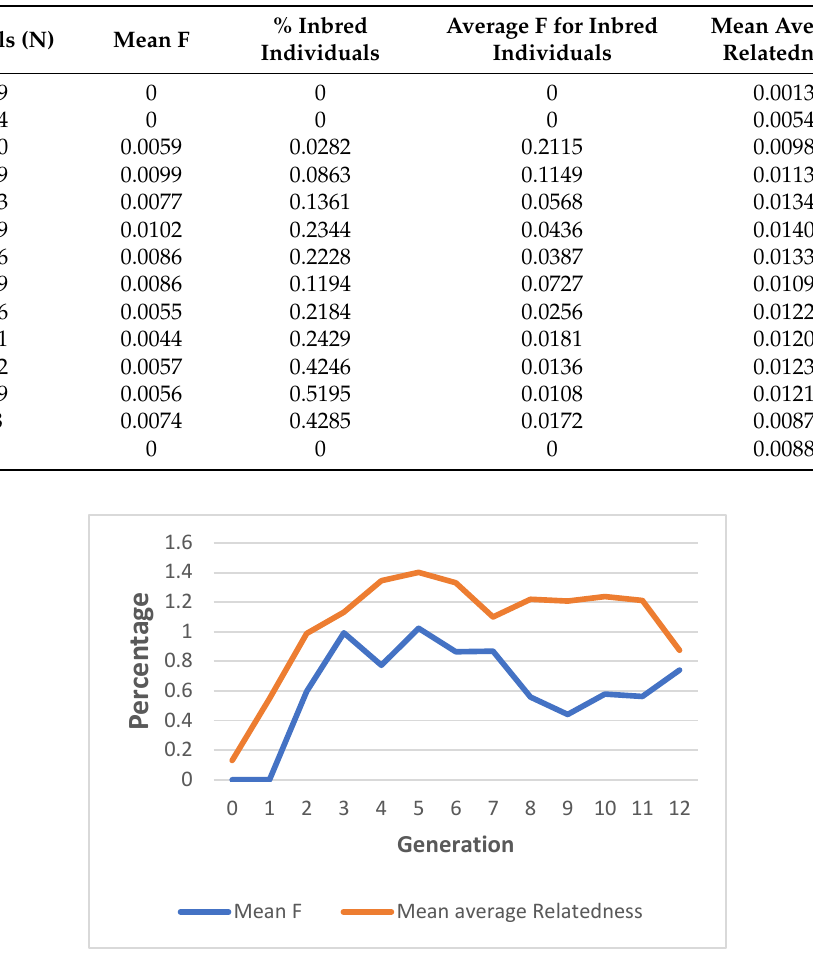
Figure 3. Inbreeding and average relatedness in Mecheri Sheep. Table 6. Mean inbreeding (F), average relatedness, and per cent pedigree completeness.